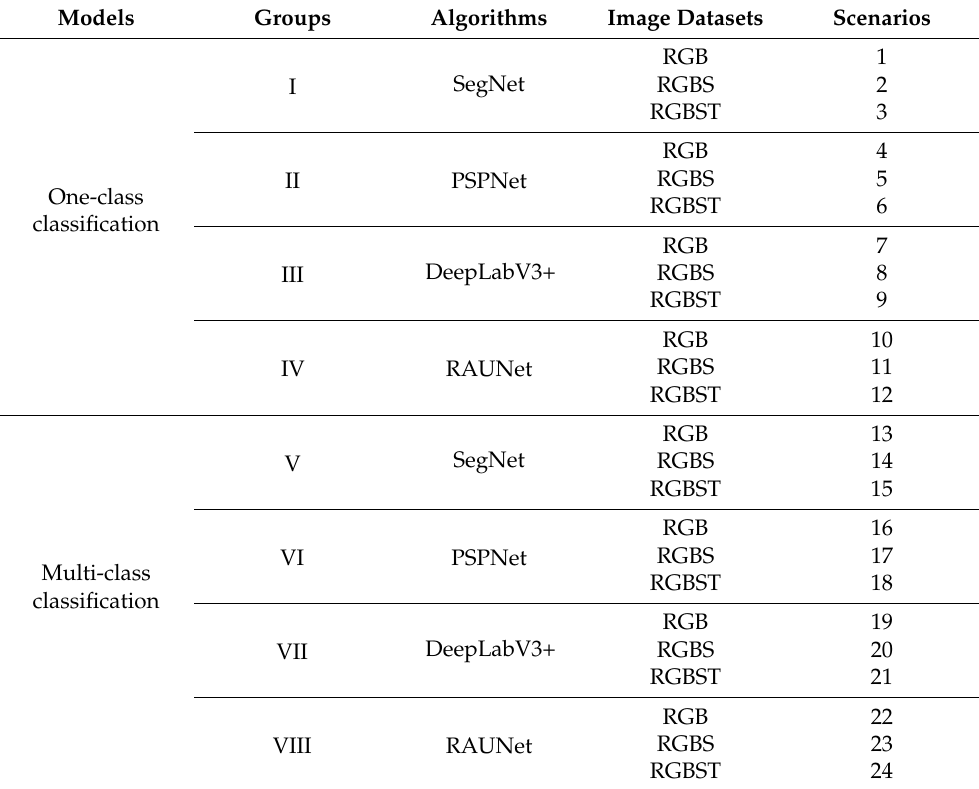
Table 3. Construction of OCC and MCC models for karst wetland